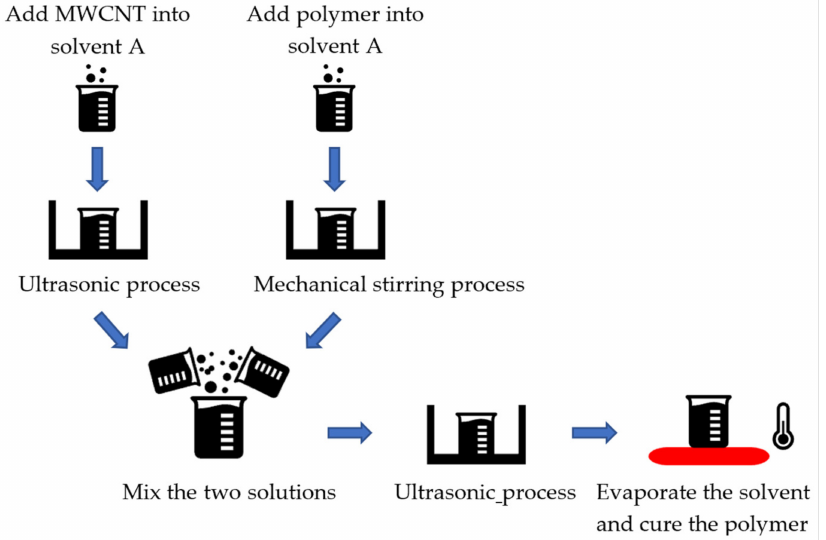
Figure 11. Solution method with the ultrasonic